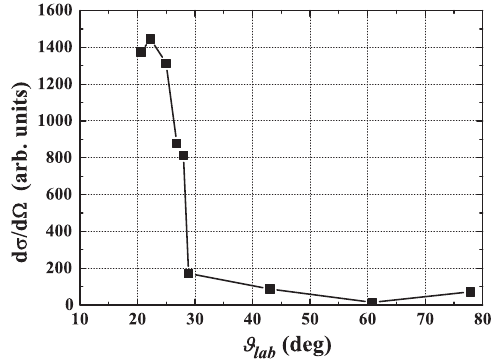
FIG. 24. Angular distribution in the laboratory reference frame of the protons corresponding to 8 Li in the ground